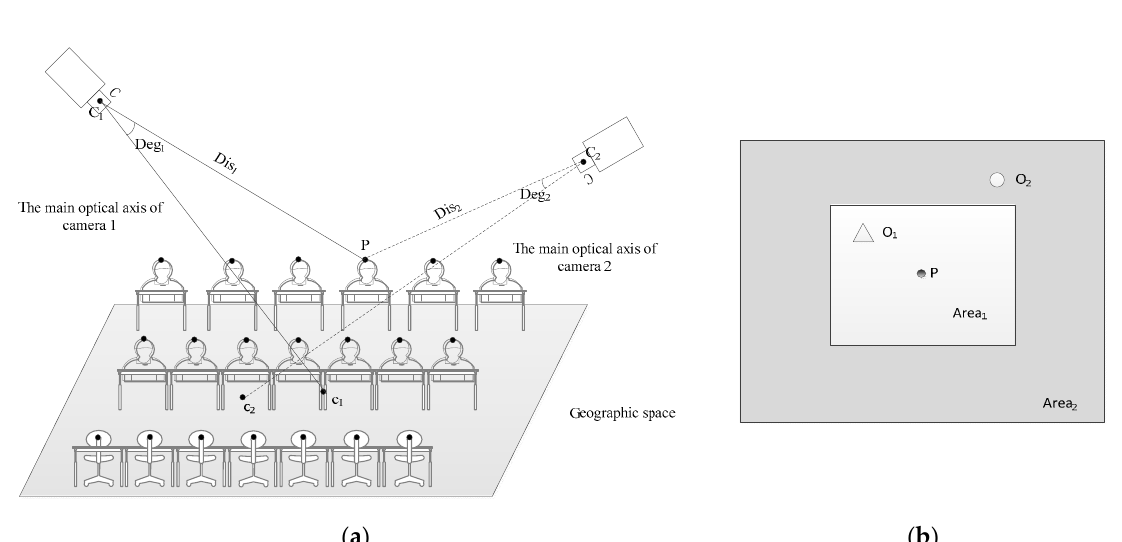
Figure 4. Object selection in overlapping FOVs. ( a ) A scene of two cameras; ( b ) the range of location P.